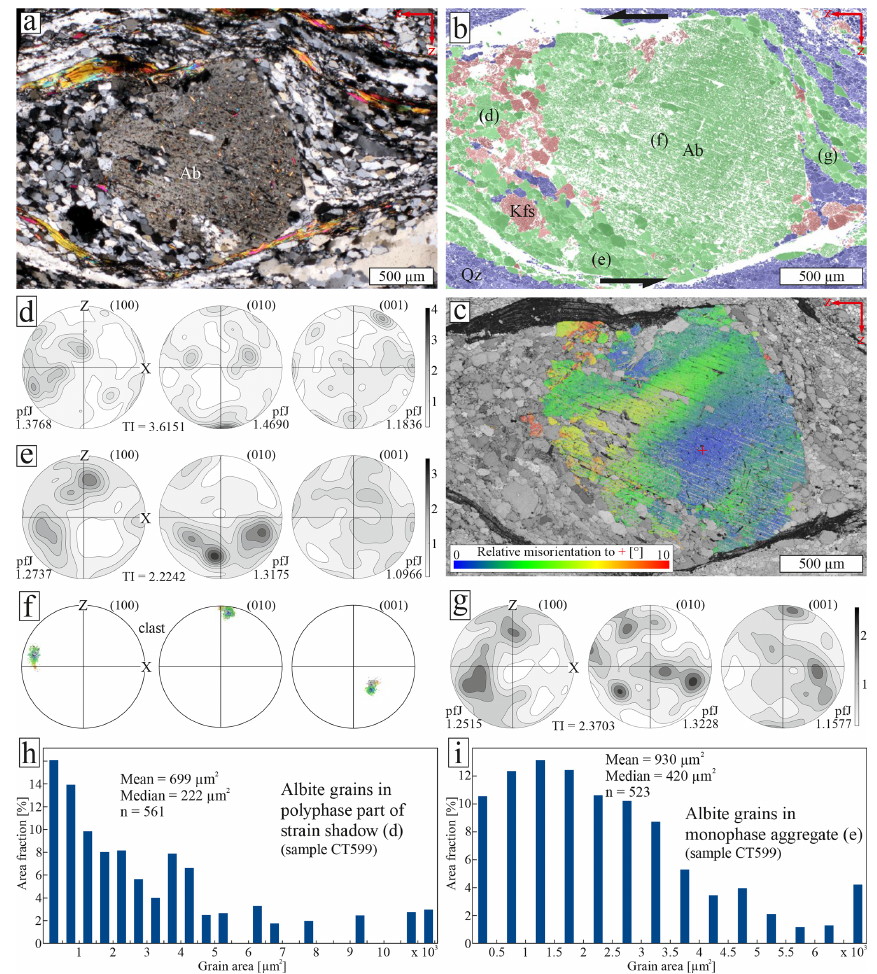
Figure 4. (a) Asymmetric strain shadow around albite porphyroclast in sample CT599 in thin-section micrograph with crossed polarizers. (b) EBSD-phase map of the same area (quartz: blue, albite: green, K-feldspar: red) and (c) EBSD-relative misorientation map (0–10 ◦ ) of the albite porphyroclast. Polyphase aggregates occur mostly in the upper left and lower right of the clast. In the other quadrants, monophase albite dominates. Pole figures show the orientation of albite in the strain shadow in the upper-left quadrant (d) , lower-left quadrant (e) , albite porphyroclast (f) and in the upper-right quadrant (g) . Grain area distribution histograms of albite in polyphase aggregates strain shadow (h) and in monophase albite aggregates (i)